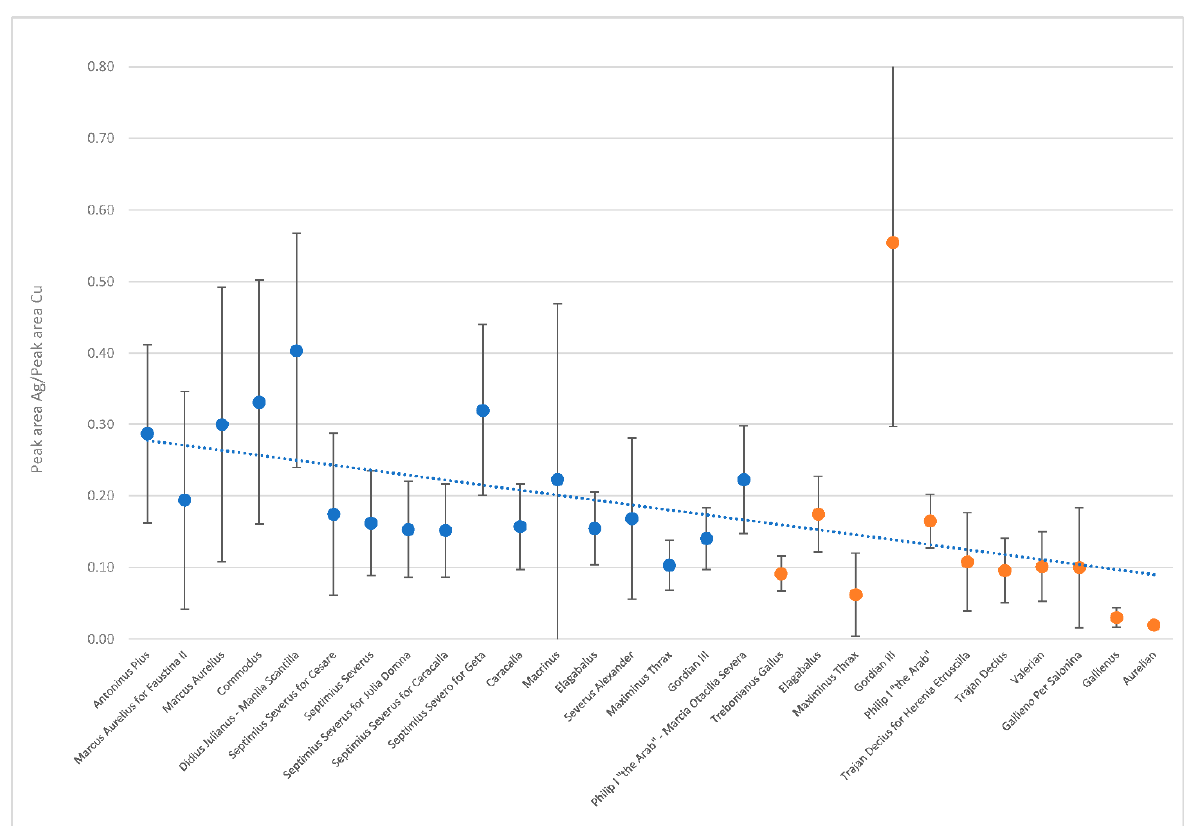
Figure 2. Average Ag/Cu ratio of the 160 coins analysed with respective error bars, denarii in blue and antoniniani in orange. The x-axis shows the emperors who issued the coins under study. The ratio reported in y-axis regards μ -EDXRF signals.